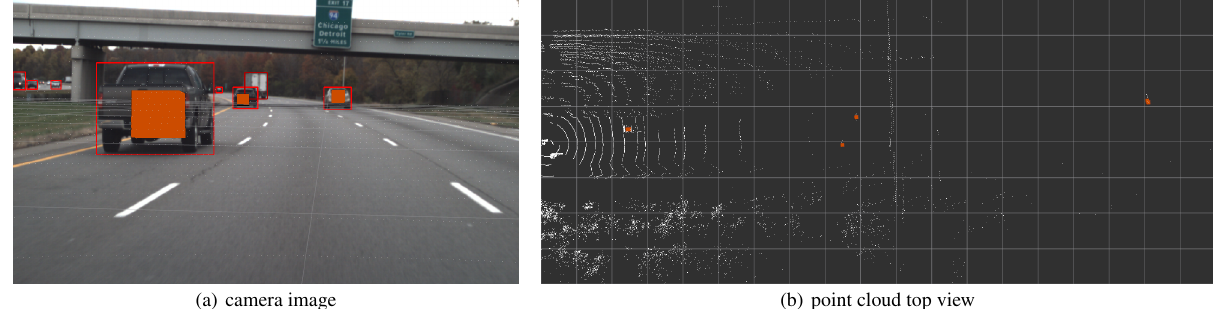
Figure 2. Object detection results on a highway scenario. (a) Camera image overlayed with bounding boxes calculated by the CNN (red rectangles around vehicles) and 3D centroids projected into the image (orange cubes). (b) Top view of the Lidar point cloud (white dots) with calculated object centroids (orange cubes). Ego vehicle is located at the left boundary of the figure. Grid cells have a size of 10 by 10 meters. Centroid of the truck in a distance ob about 170 m is not shown in the image.